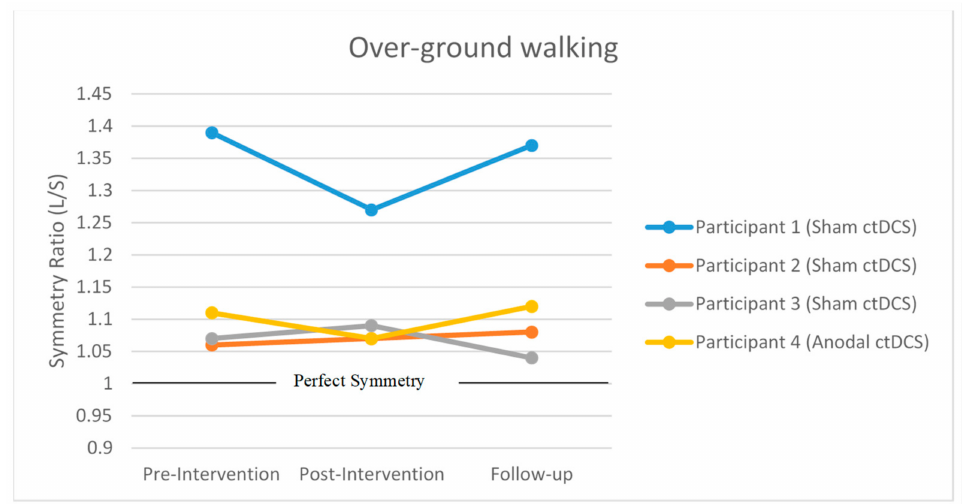
Figure 6. Mean over-ground step length at pre-intervention, post-intervention and follow-up assessment session. The black horizontal line represents perfect symmetry. L: longer step length, S: shorter step length.